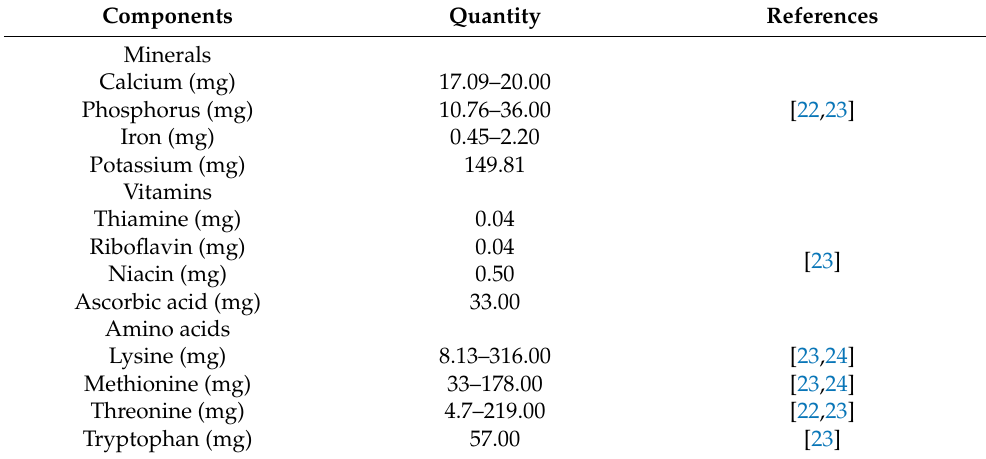
Table 2. Composition of minerals, vitamins, and amino acids in bacuri pulp ( Platonia insignis Mart.).